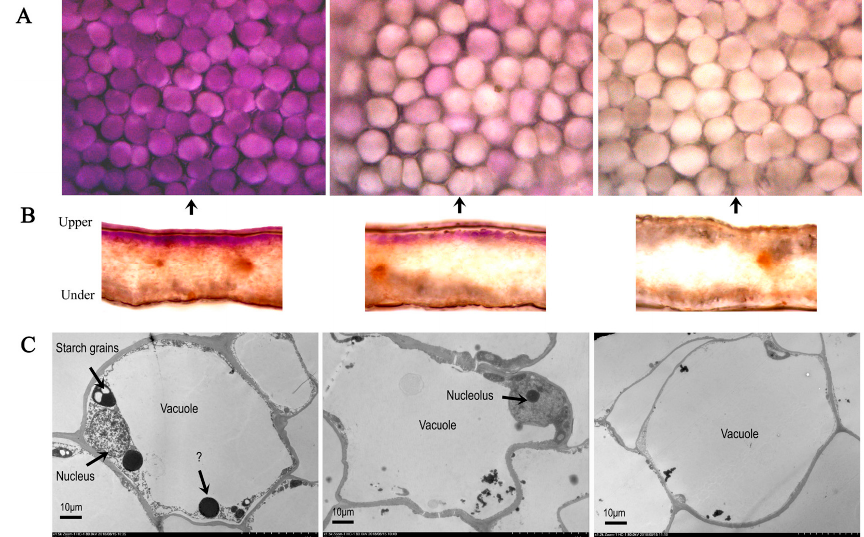
Figure 2. The pigment distribution and ultrastructure of epidermal cells in different days. Longitudinal section of the petal epidermis ( A ) and the petal upper epidermis under a microscope magnified 20 times ( B ); the petals of ultrastructure in upper epidermis of 10 µm ( C ).